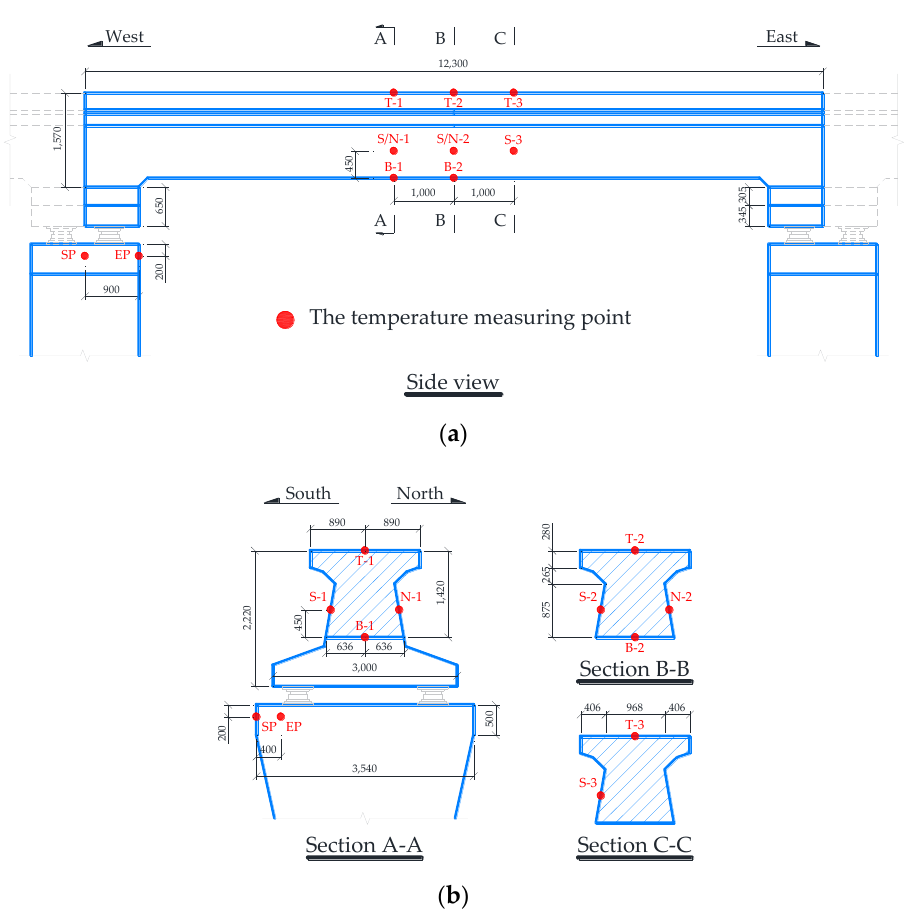
Figure 8. Arrangement of temperature measuring points (unit: mm). ( a ) Elevation view; ( b ) key section layout.